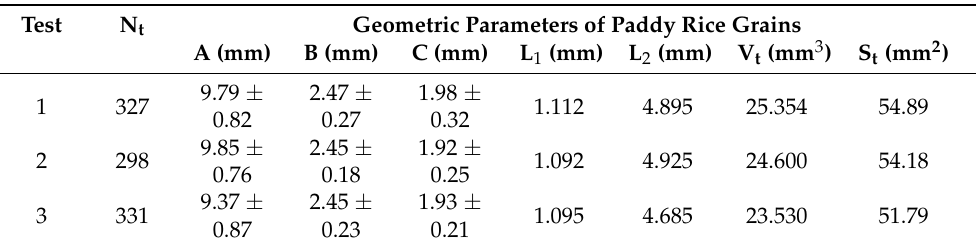
Table 3. Dimensional data, volume and surface area and total number of paddy rice grains before microwave drying.